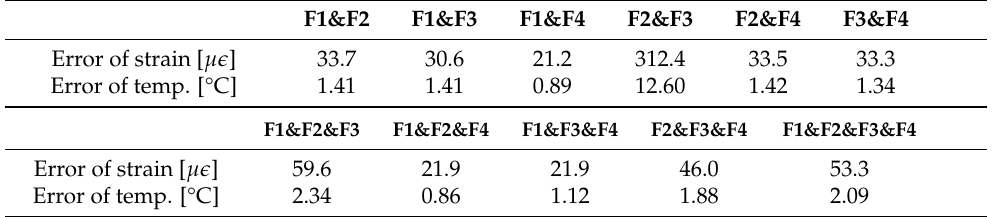
Table 6. Calculated errors when using the Monte Carlo